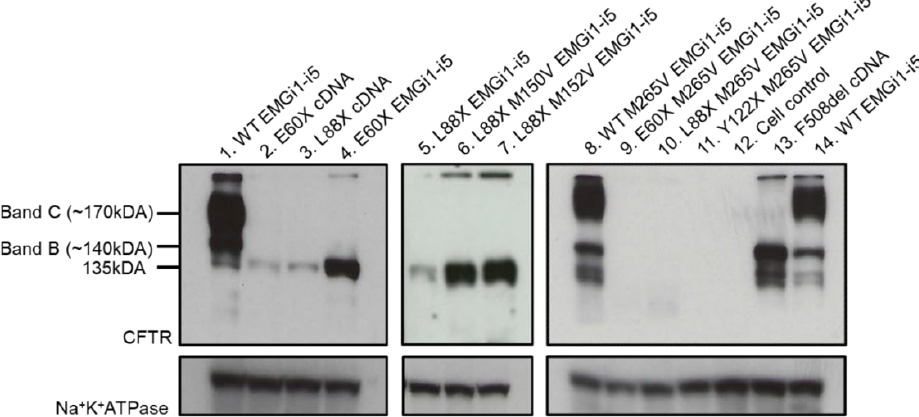
Figure 1. AUG codon at position M265 is used as an alternative downstream translation initiation site for N-terminal CFTR nonsense variants. Immunoblot showing steady state levels of CFTR protein. Band B is immature, core-glycosylated CFTR protein and band C is mature, complex-glycosylated CFTR protein. Na + K + ATPase shown on bottom as a loading control. Protein lysates were collected from HEK293 cells transiently transfected with intronless cDNA or CFTR -EMGs bearing N-terminal nonsense variants and downstream methionine mutations. HEK293 cells expressing WT- CFTR -EMGi1-i5 and intronless F508del CFTR served as positive controls, and non-transfected HEK293 cells as a negative control (cell control). Immunoblot was probed with anti-CFTR antibody, 596.